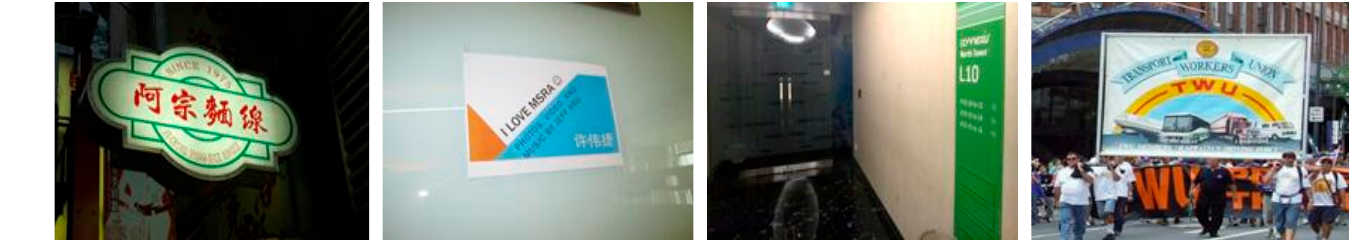
Figure 1. Different kinds of text instances in scene text, including straight text, horizontal text, curved text, and multilingual text.